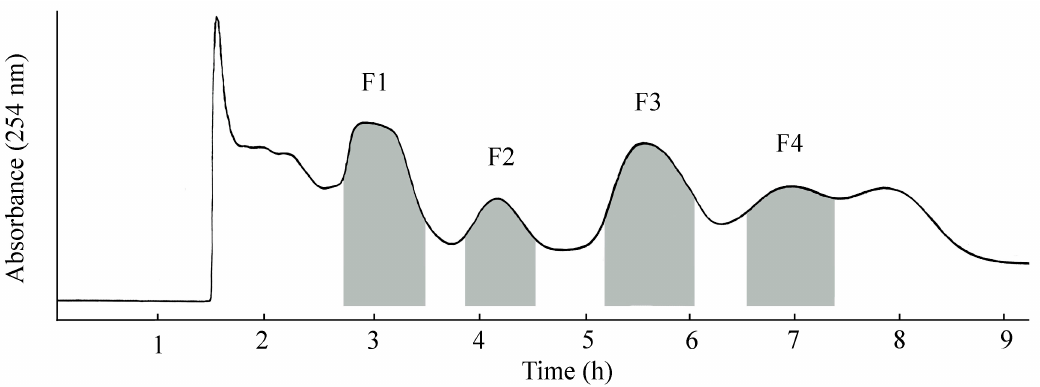
Figure 3. Chromatogram of the crude extract by HSCCC. Two-phase solvent system: methyl tert -butyl ether/ n -butanol/acetonitrile/water (0.5% acetic acid) (2:2:1:5, v/v ); Mobile phase: the lower phase; Flow